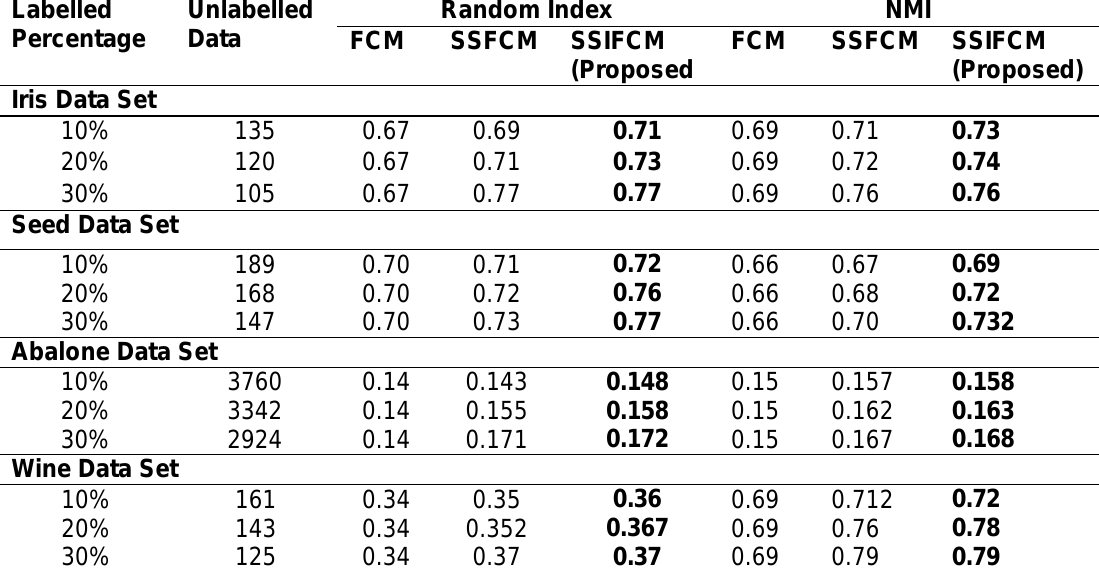
Table 6. Comparative analysis of SSIFCM algorithm with FCM and SSFCM in terms of Random Index and NMI